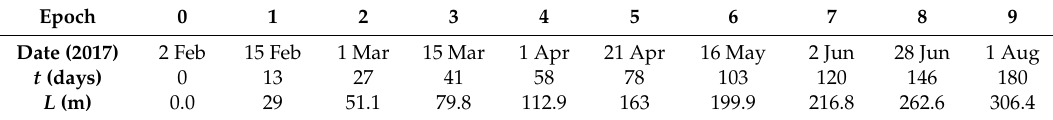
Table 3. Epochs time-table and measured lengths of the excavated space.